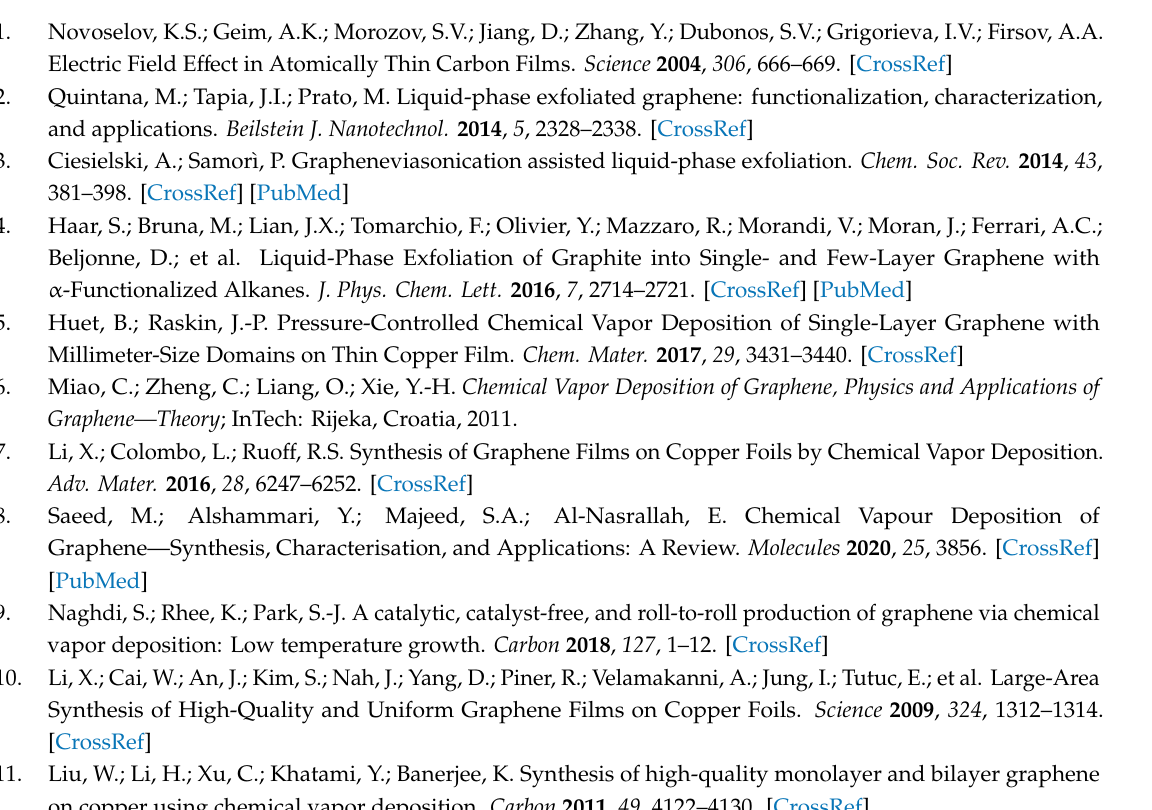
Table S1: The weight of elemental metal used to form each Cu–Sn alloy composition, Table S2: Summary of the used APCVD graphene growth parameters on liquid Sn to study the e ff ect of CH 4 concentration and residence time, Table S3: APCVD graphene growth parameters on liquid Sn using di ff erent H 2 flow rates, Table S4: APCVD graphene growth parameters on liquid Sn using di ff erent Ar flow rates, Figure S1: Photograph of the CVD reaction tube showing the change in colour of the tube’s inner walls turning to black due to saturation of carbon species after using growth temperature 1140 ◦ C for 5 min, Table S5: Optimised growth parameters for APCVD graphene on liquid Sn, Table S6: EDX compositional analysis of samples after APCVD graphene growth, in order to make comparisons with the initial compositions, Figure S2: Solubility of hydrogen in liquid Cu–Sn alloys as a function of Sn wt.% at 1100 ◦